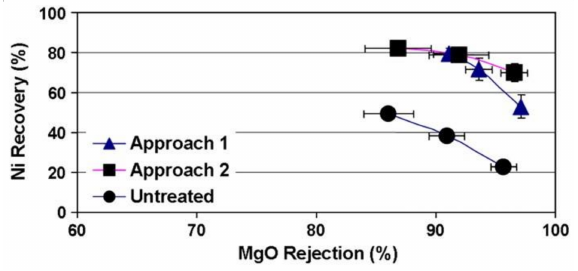
Figure 5. Nickel recovery vs. MgO rejection: treated (approaches 1 and 2) vs. untreated ore. Approach 1: 2-h aging and frother (DF250) addition; Approach 2: 5-min aeration, no frother for cons 1 and 2. Reprinted with permission from Uddin et al. [50]. Copyright 2012 Elsevier Ltd.